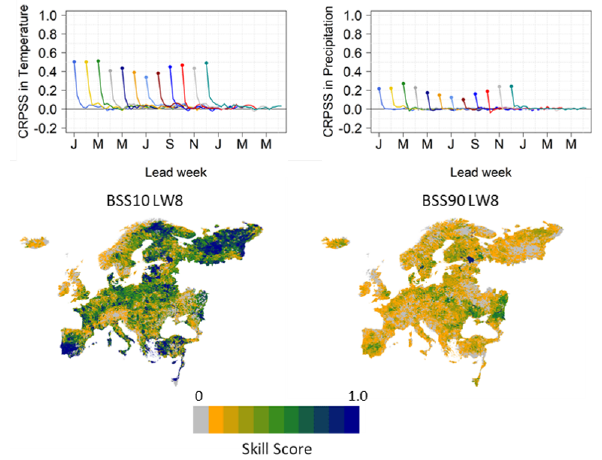
Figure 4. Median prediction skill over the pan-European domain in terms of CRPSS after bias-adjustment for temperature (top left) and precipitation (top right) for all initialization months and lead months. The bottom row shows the prediction skill in terms of BSS for low (BSS10) and high (BSS90) river discharges and for lead week 8.